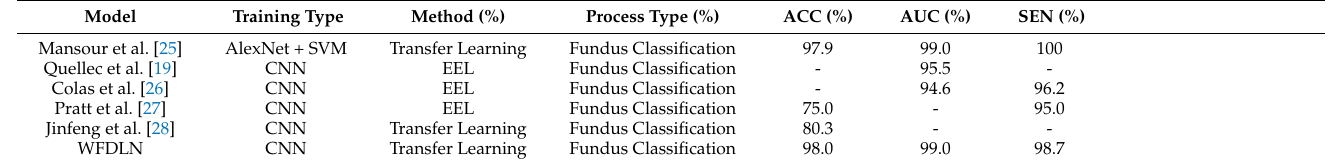
Table 5. Result comparison of our proposed model with up-to-date methods on Kaggle dataset for fundus classification. EEL stands for end-to-end